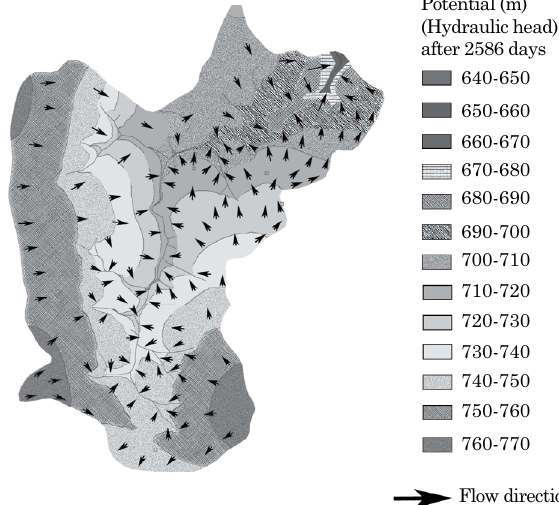
figure 4. Potentiometric surface obtained after running the model. Vectors in black represent the darcy velocities.